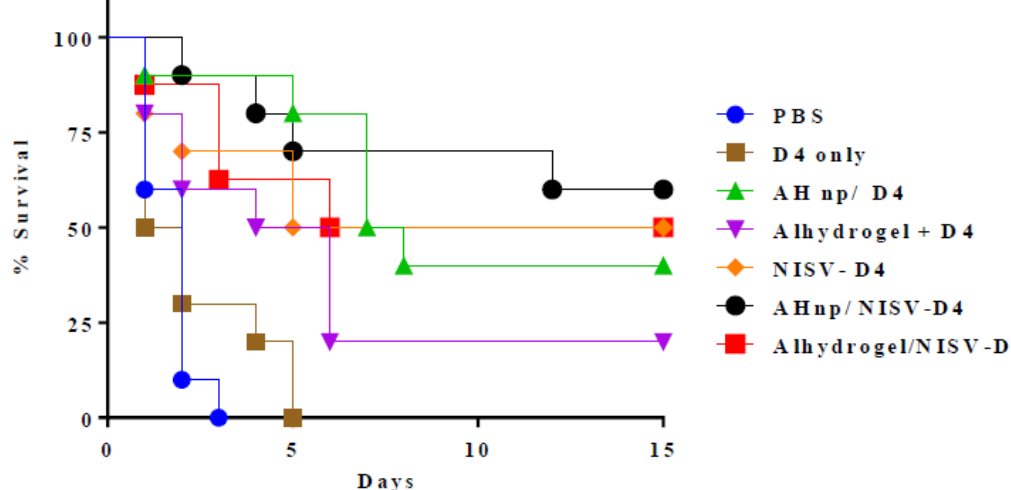
Figure 5. Protective efficacy of the vaccine formulations against BA spore challenge was checked in Swiss albino mice. Fourteen days after the 2nd booster, immunised mice were administered with 0.5 × 10 3 spores of a virulent strain of BA. Infected mice were kept in an animal isolator in BSL 3 and observed for death and morbidity for 14 days.